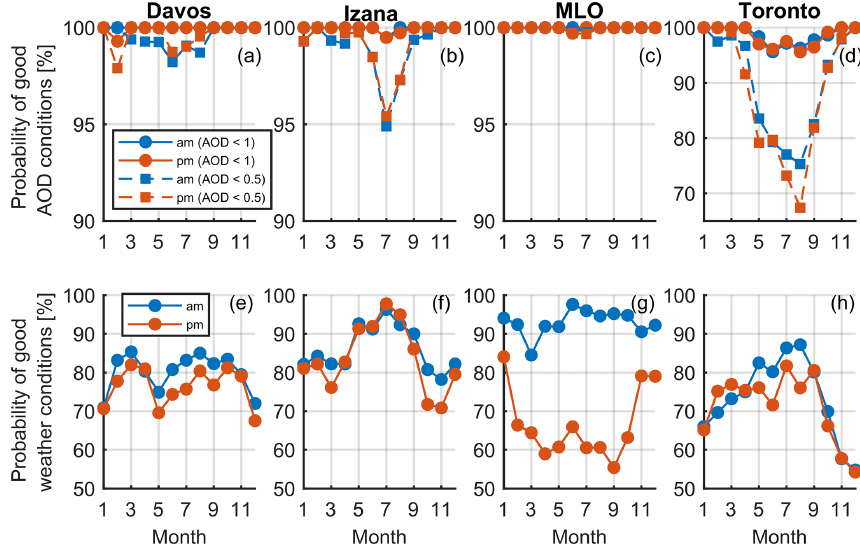
Figure 6. Probability of good AOD and weather conditions for Brewer’s primary calibration at four sites in 2005–2020. AOD conditions were estimated via sun photometer observations, while weather conditions were estimated via Brewer direct-sun ozone observations. Note that panel (d) used a different y axis scale than panels (a–c)